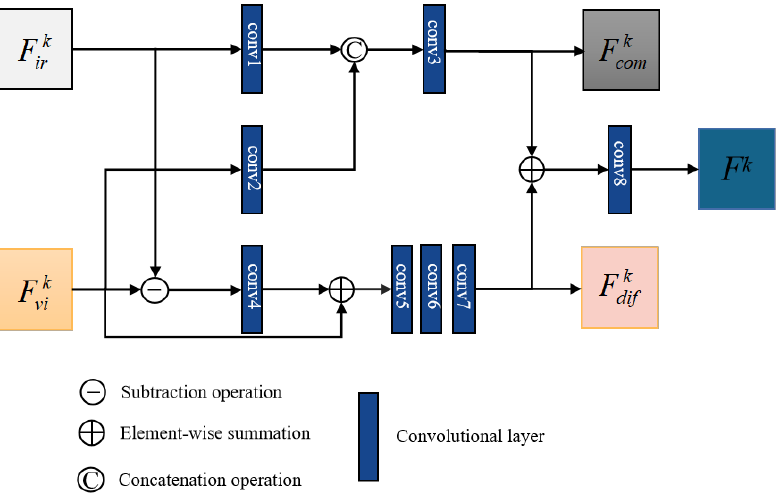
Figure 2. The proposed DHFS